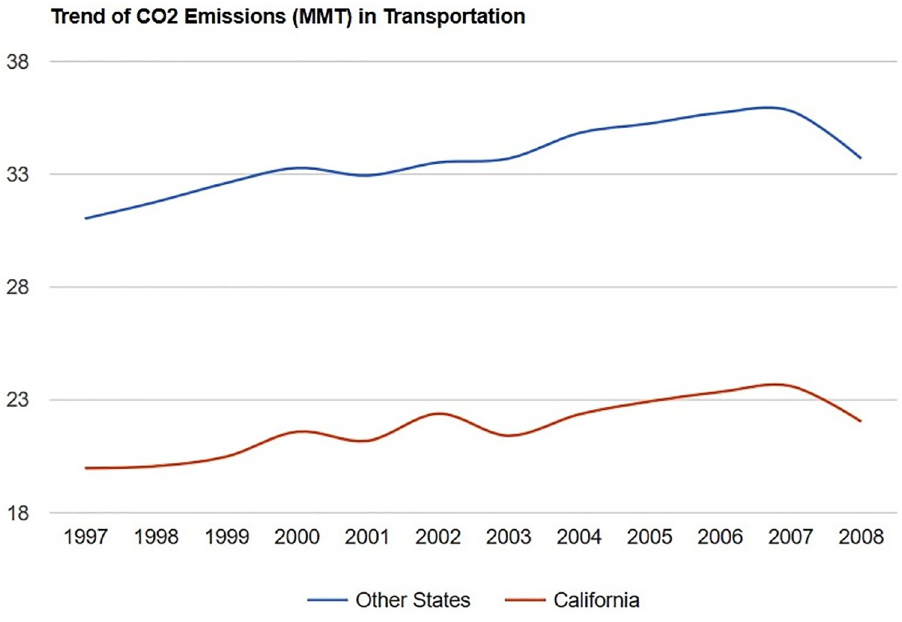
Fig 1. Testing the validity of the parallel trend assumption for the DID